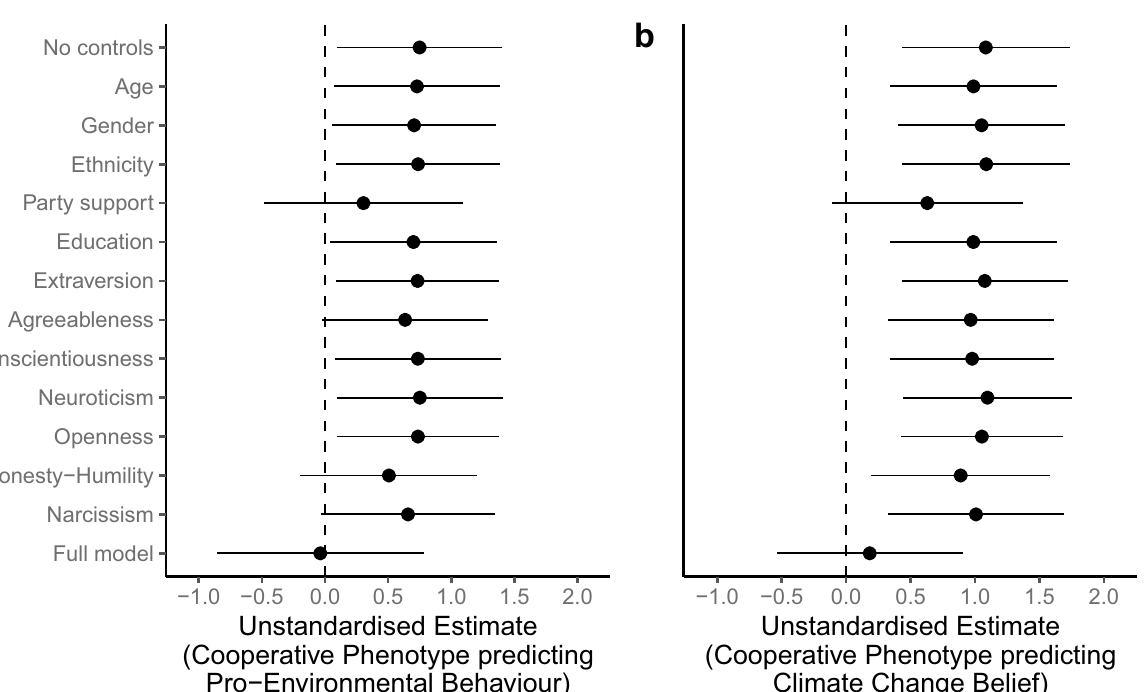
Figure 2. Controlling for socio-demographic and personality variables. ( a ) The unstandardized estimate for the relationship between the cooperative phenotype factor and pro-environmental behaviour, across various models controlling for different socio-demographic and personality variables. ( b ) The unstandardized estimate for the relationship between the cooperative phenotype factor and climate change belief. Lines represent 95% confidence